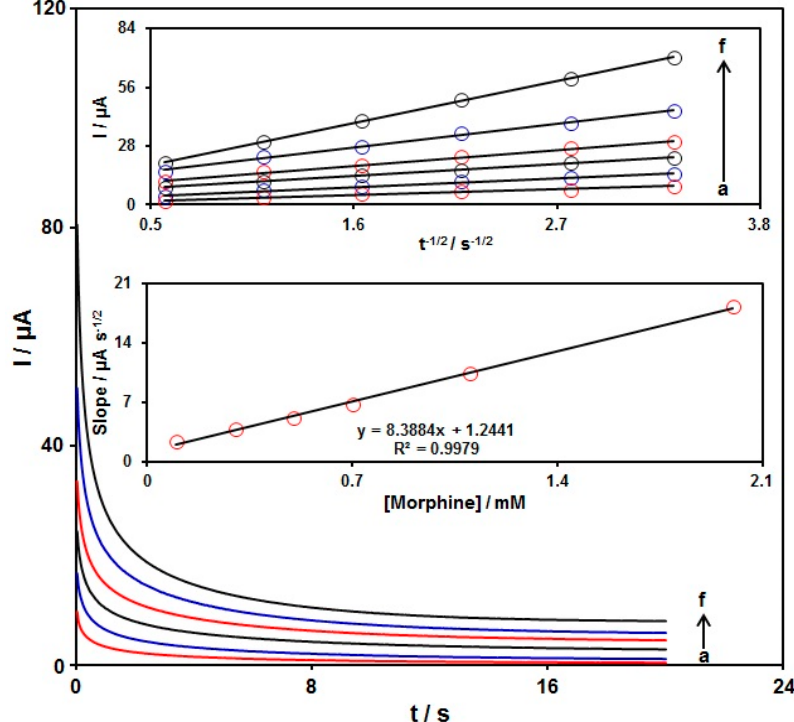
Figure 8. Chronoamperometric behavior of graphene-Co 3 O 4 /SPGE in PBS (0.1 M; pH = 7.00) at a potential of 300 mV for variable morphine contents (a–f: 0.1, 0.3, 0.5, 0.7, 1.1, and 2.0 mM); Insets: (top) plots of I vs. t − 1/2 ; (bottom) plots of the slopes from the straight lines vs. morphine level.